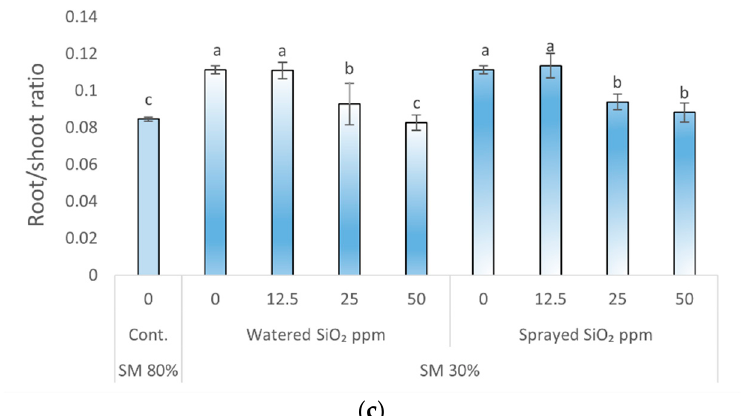
Figure 1. Effect of drought stress and SiO 2 NPs (0; 12.5; 25; and 50 ppm) on relative water content (%), specific leaf area (cm 2 g − 1 ), and root/shoot ratio in P. sativum L. Cont.—control plants, substrate moisture (SM) 80%; drought stress—SM 30%, RWC ( a ); specific leaf area ( b ); root/shoot ratio ( c ). Values are mean ± SE of 10 replicates and different letters are differed significantly by Tukey HSD Test ( p < 0.001).